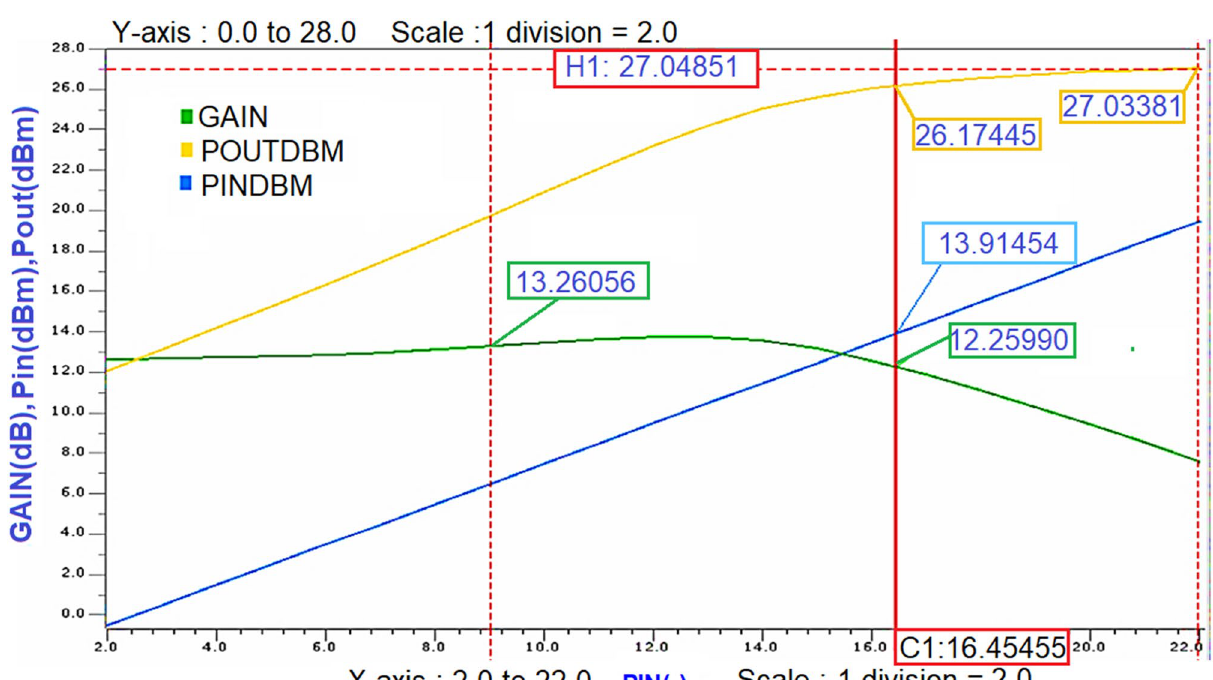
Figure 23. The 1 dB compression point and saturated power (Psat) of Class-J